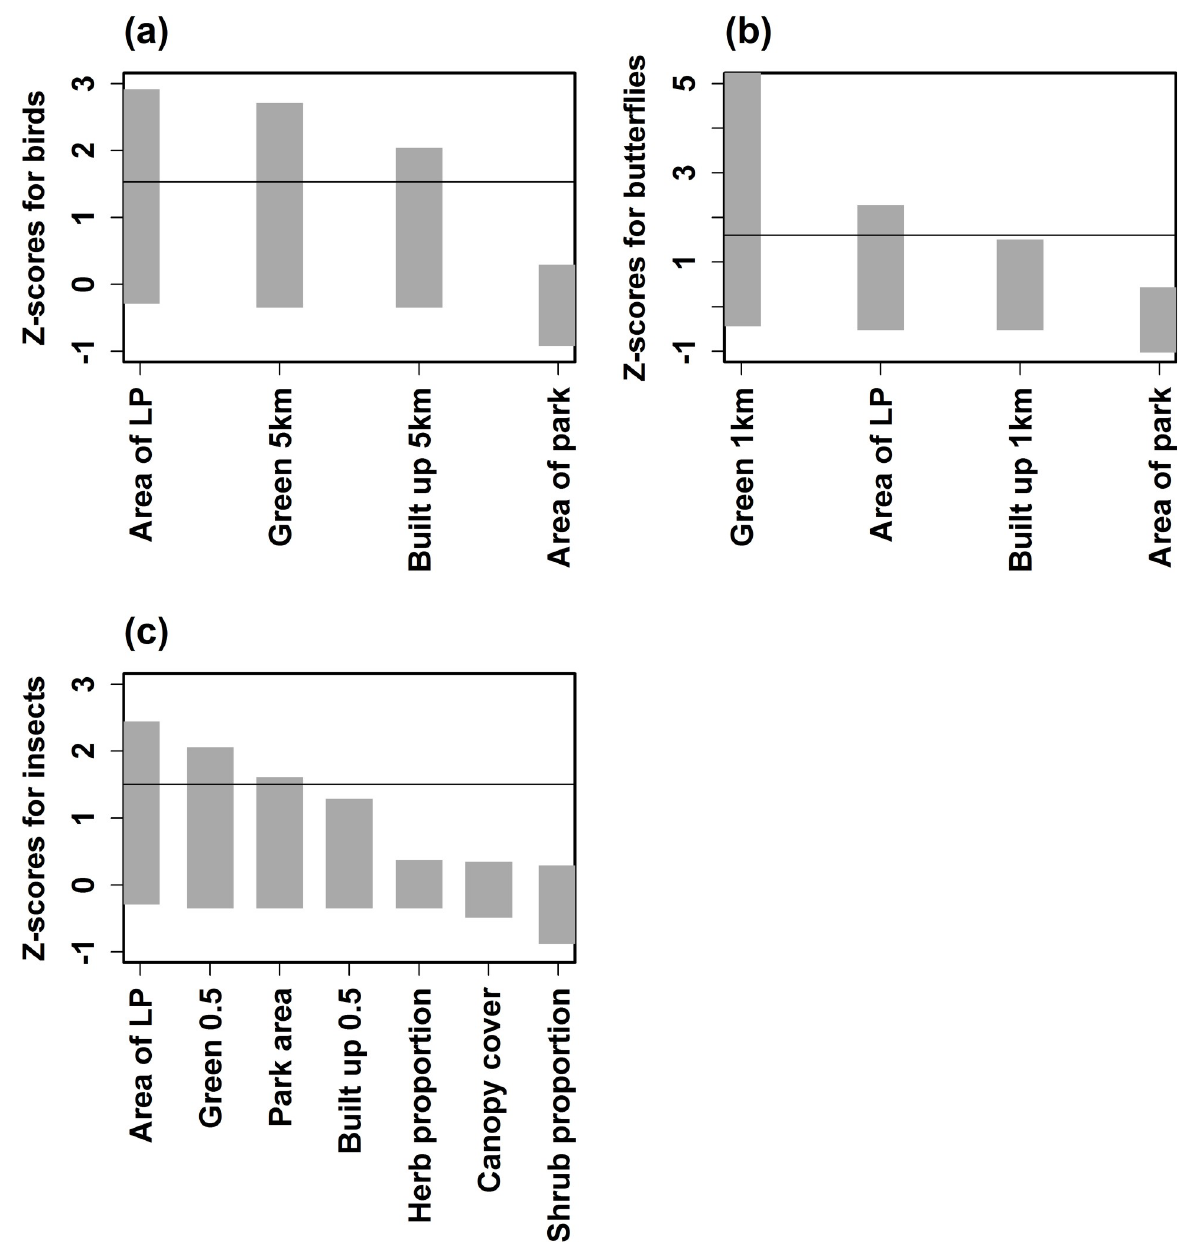
Fig 6. Hierarchical partitioning to determine variables that influence (a) Birds; (b) Butterflies and (c) Insects at neighbourhood scale. fragmented landscape, butterflies are more dependent on the density of green spaces at the neighbourhood scale. Suggesting that along with microhabitat composition and heterogeneity within NPs, the neighbourhood matrix within which NPs are embedded plays a crucial role in determining the local biodiversity. Birds are dependent on LGS, however, we recorded the Greenish Leaf Warbler ( Phylloscopus trochiloides ) and Blyth’s ReedWarbler ( Acrocephalus dumetorum ) which are migrant bird species, within neighborhoods which comprised several unmaintained vacant sites comprising wild vegetation surrounding the NPs. Neighbourhood